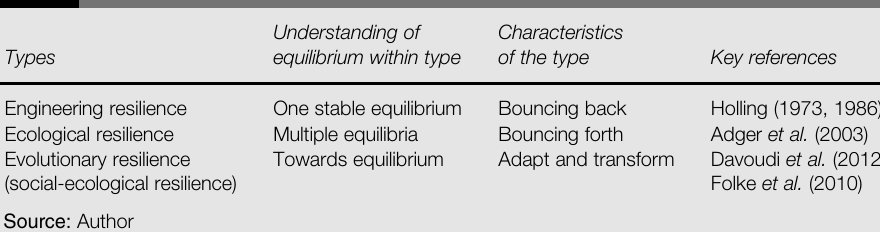
Table I An overview of perspectives on